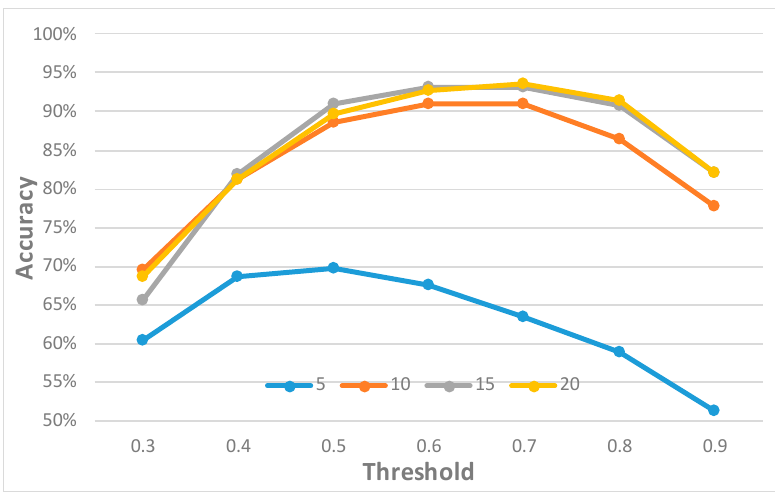
Figure 7. The influence of the number of 3D models used for training on the identification accuracy.